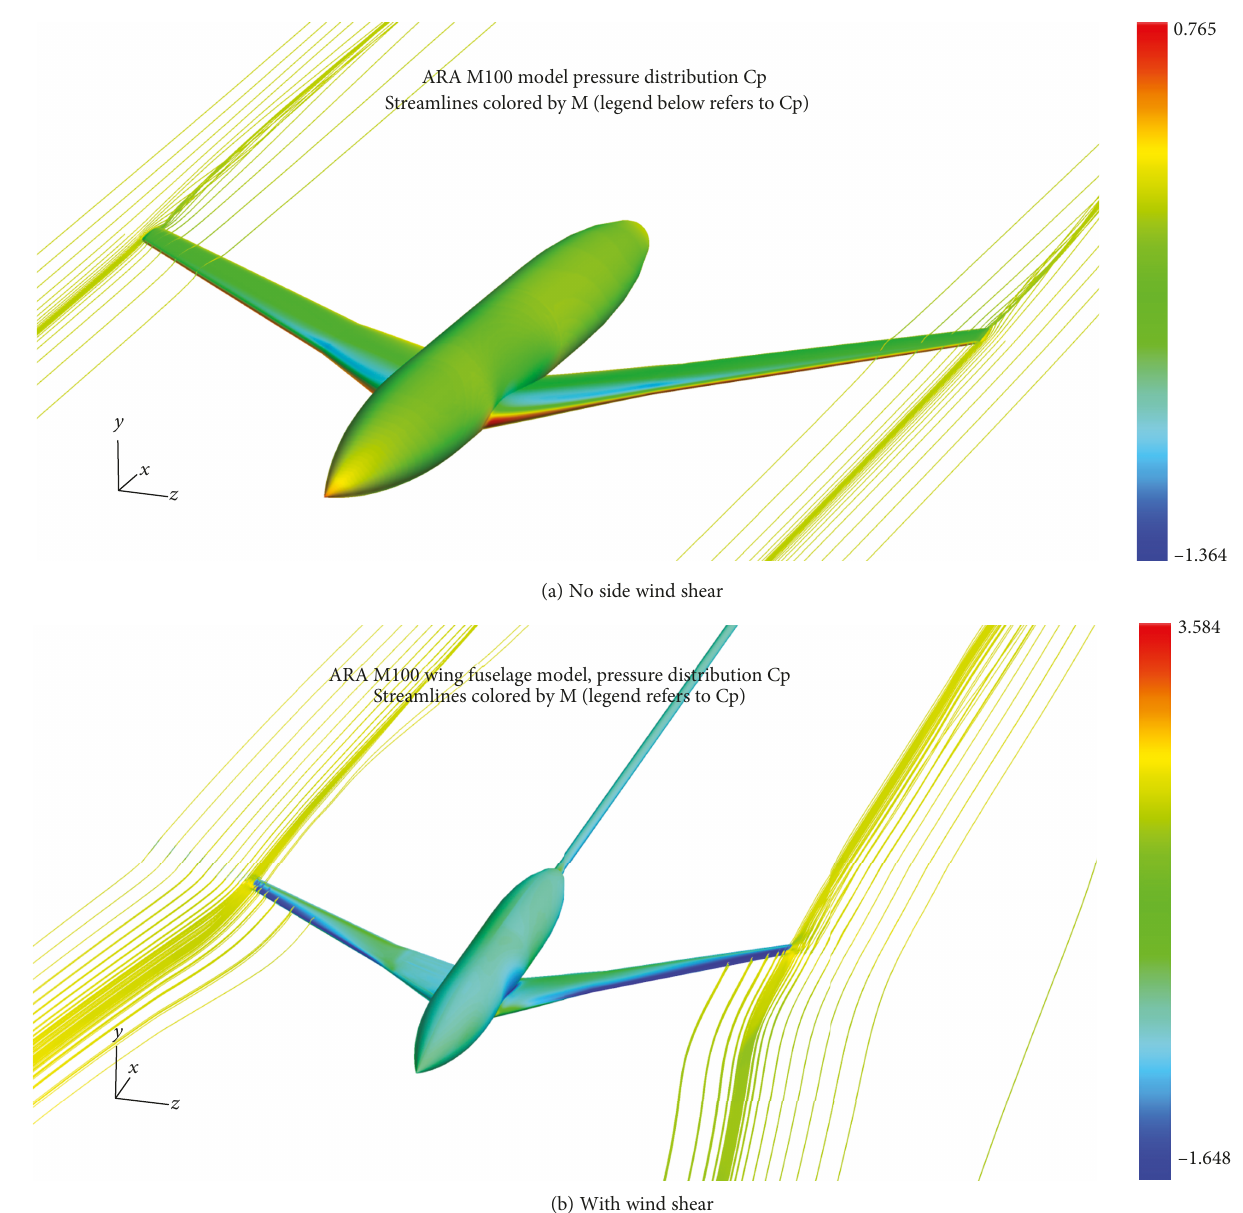
Figure 27: Cp distribution and wing tip streamlines on ARA M100 wing-fuselage con fi guration. M = 0 6 , α = 1 733 ° , and Re/m = 13 × 10 6 ; (a) without side wind shear and (b) wing wind